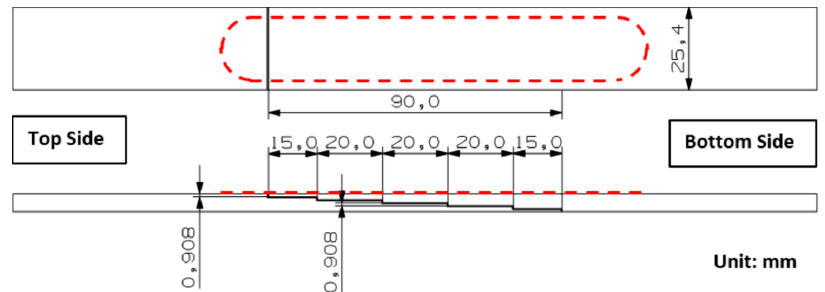
Figure 3. Schematic drawing of step lap joint composite specimen (red dotted lines indicate the location of bonded fibre) and showing the clamped side.